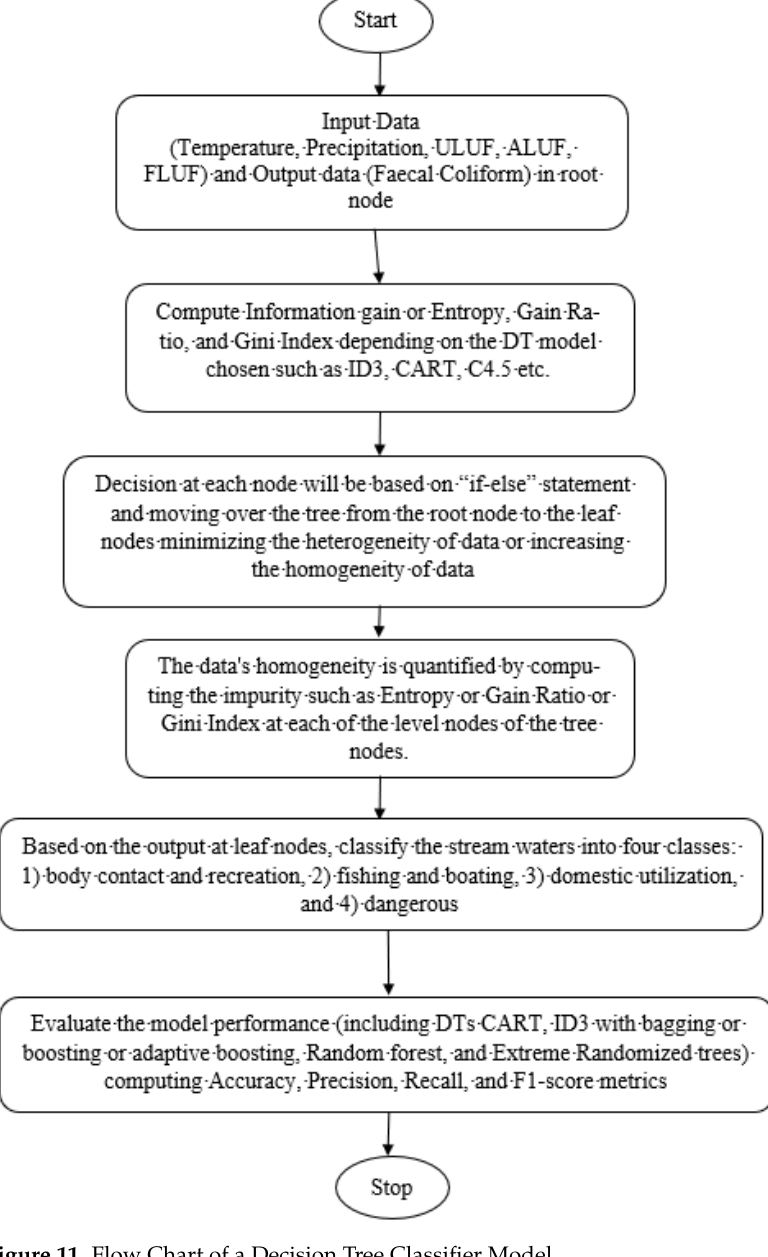
Figure 11. Flow Chart of a Decision Tree Classifier Model.